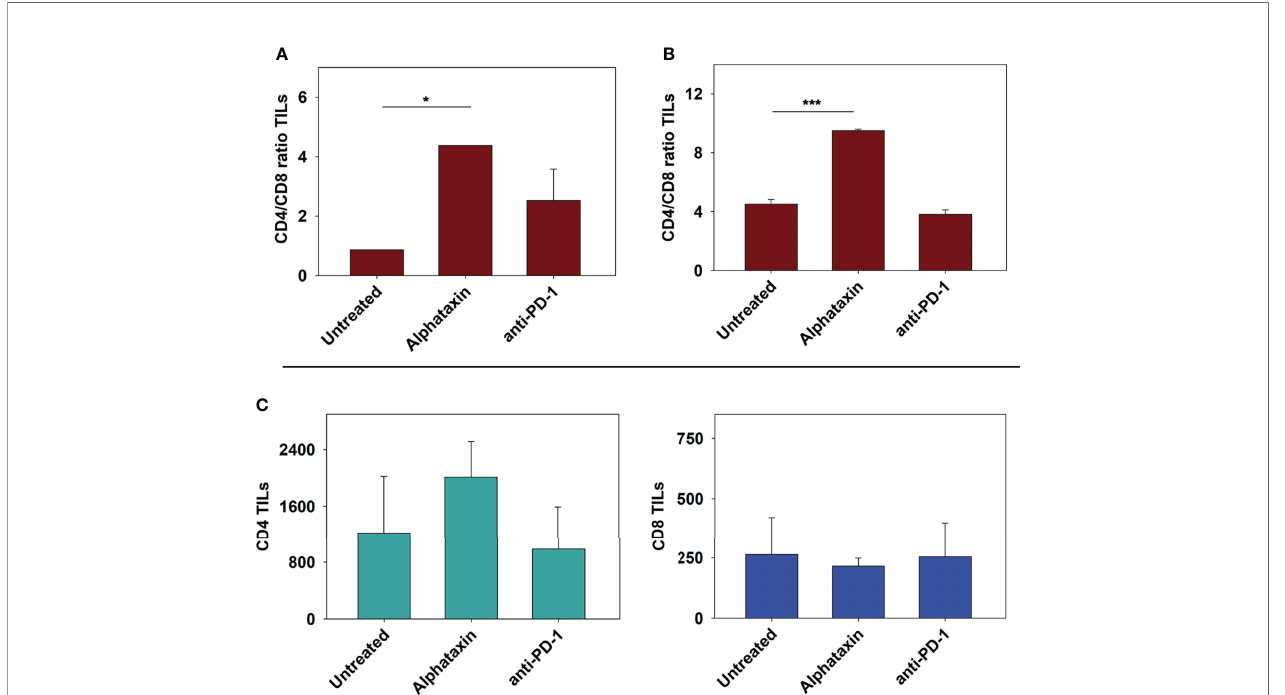
FIGURE 8 | Increases in the Tumor-in fi ltrating CD4/CD8 Ratio Achieved by Treatment with Alphataxin or an Anti-PD-1 Antibody. Excised kidneys from mice in each treatment arm of (5 x 10 2 orthotopically implanted Renca cells and 5 x 10 3 orthotopically implanted Renca-GL cells) were immunohistochemically stained to determine the numbers of CD4 + and CD8 + TILs which were counted in all the tumor fi elds of the stained slides. Because the tumors varied in size, yielding large variation in the number of TILs, the CD4/CD8 ratio is depicted to produce more accurate comparisons. (A) In the Renca cell orthotopic study, after 21 days of treatment, the tumor-in fi ltrating CD4/CD8 ratio in Alphataxin-treated animals was signi fi cantly greater than that in untreated and anti-PD-1 antibody-treated mice ( P = 0.04). (B) In the Renca-GL study, tumor-in fi ltrating CD4/CD8 ratio in Alphataxin-treated mice was signi fi cantly greater than that in untreated ( P < 0.001, n = 3) and anti-PD-1-treated mice ( P < 0.001, n = 3). In anti-PD-1 treatment, CD4/CD8 ratio was signi fi cantly greater than in untreated animals ( P = 0.02, n = 3). Combination treatment is not depicted due to the lack of suitable kidney sectioning. Means and standard deviations are depicted. The CD4/CD8 ratios were not normally distributed and were compared by the Mann-Whitney rank- sum test. (C) In the Renca-GL study, there were more CD4 + TILs (green bars) in the tumors of Alphataxin-treated mice than in those of anti-PD-1 antibody-treated mice ( P = 0.086, n = 3), which demonstrates practical statistical importance. The numbers of CD8 + TILs (blue bars) were not different among the treatment arms ( P = 0.94), n =3). Note that the scales for the CD4/CD8 ratio and TIL counts are not equivalent in different graphs. TILs were normally distributed and were tested by ANOVA. Asterisks designate statistically signi fi cant differences (*P < 0.05, ***P <